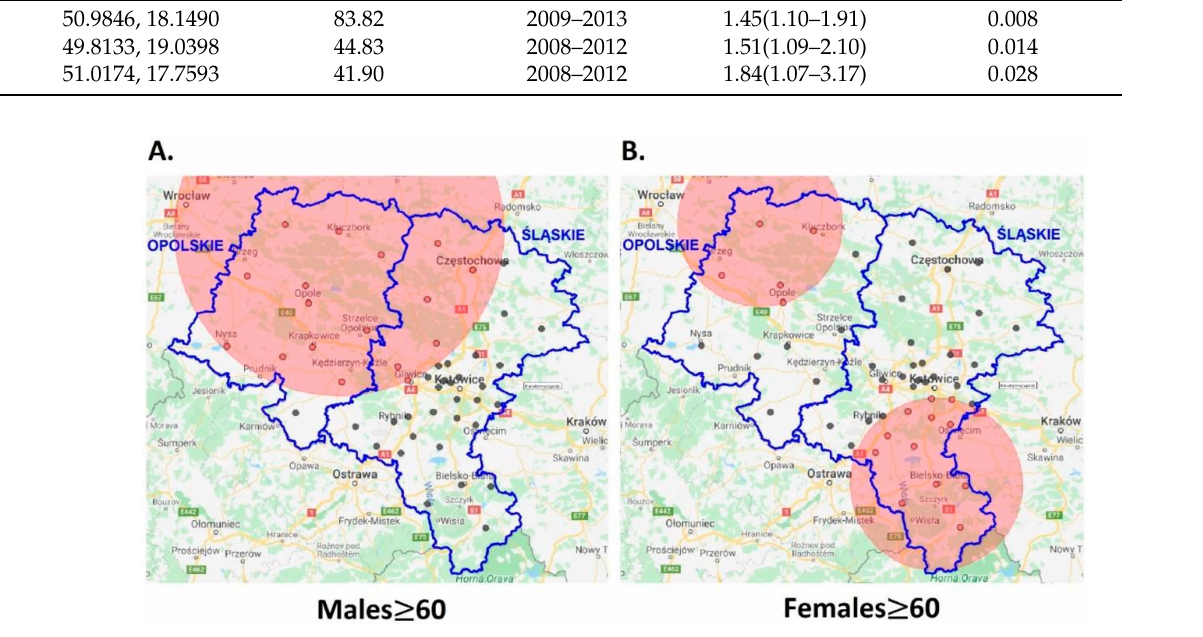
Figure 5. Statistically significant ( p < 0.05) spatio-temporal cutaneous MM disease clusters ( ≥ 60) in males (Panel ( A )) and females (Panel ( B )) in Upper Silesia (with geographical centers of administra- tive